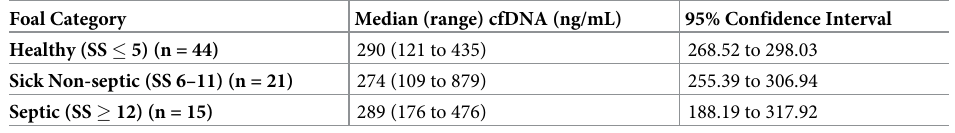
Table 1. Cell-free DNA concentrations in 80 hospitalized neonatal foals based on sepsis score cut-off values alone (excluding blood culture status), including 44 healthy foals, 21 sick non-septic foals and 15 septic foals.